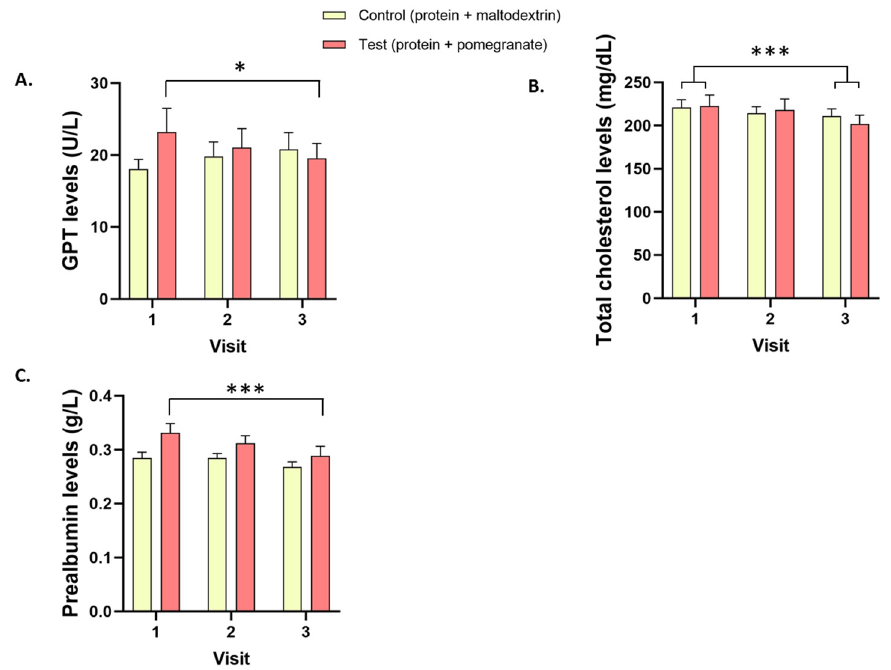
Figure 3. Glutamate pyruvate transaminase, total cholesterol, and prealbumin levels. Plasma ( A ) glutamate pyruvate transaminase (GPT), ( B ) total cholesterol, and ( C ) prealbumin levels in the Test and Control groups at V1, V2, and V3. * p < 0.05, *** p < 0.001. Table 2. Physical, hematological, and biochemical parameters.